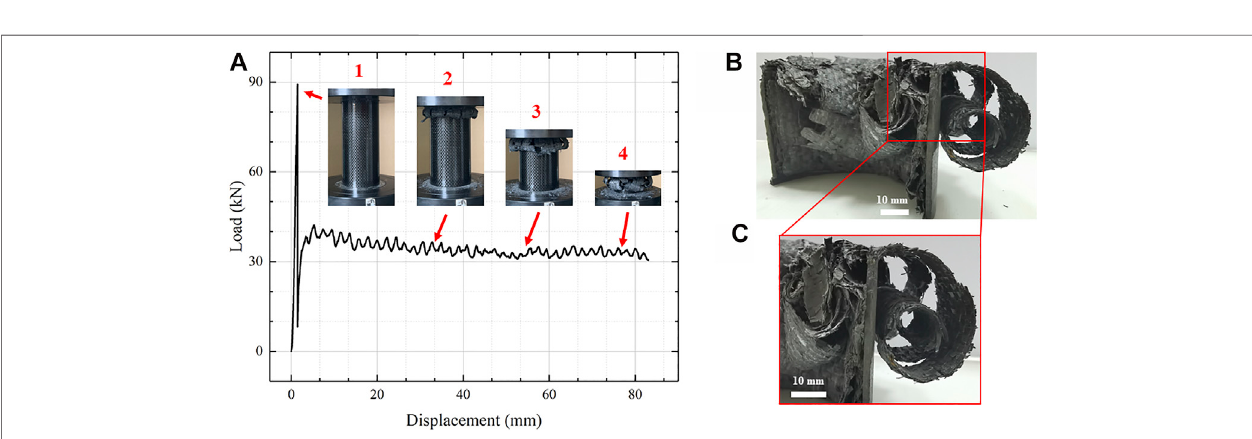
FIGURE 5 | (A) Load – displacement curve with deformation modes of CFRP tube, (B) pro fi le view of the crushed CFRP tube, and (C) detailed view.